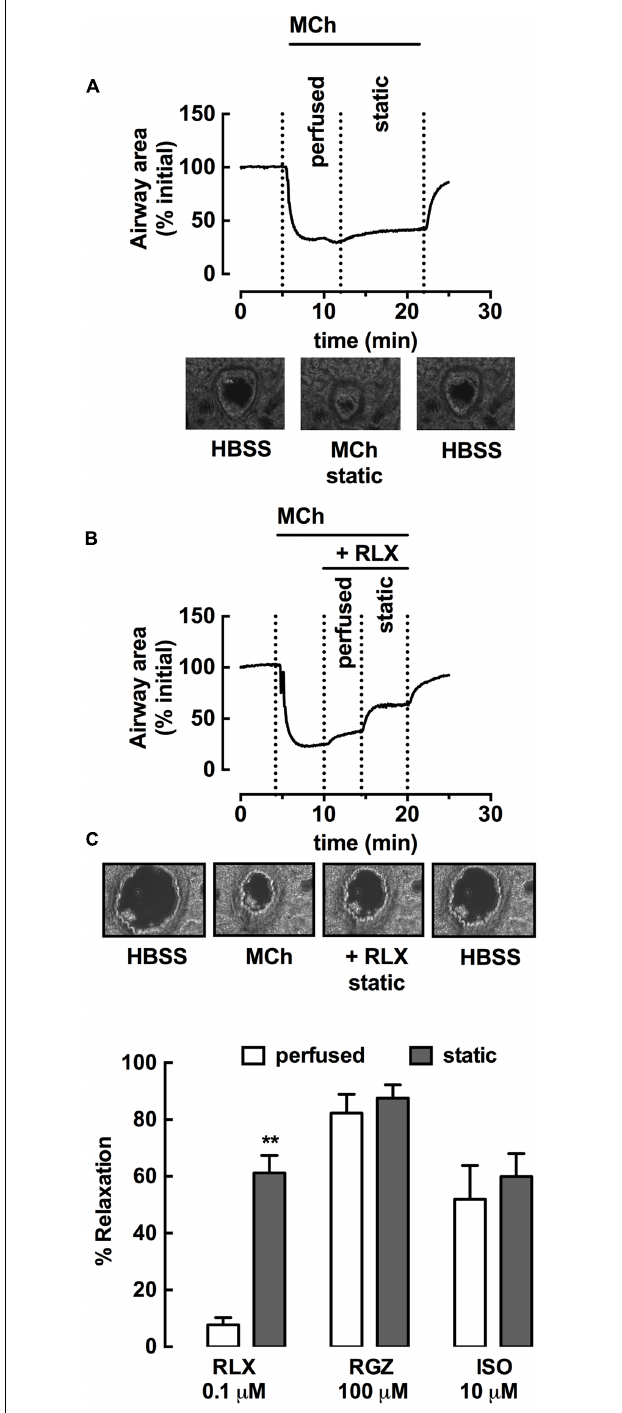
FIGURE 4 | rhRLX elicits relaxation of rat intrapulmonary airways in lung slices. Rat lung slices were mounted in a customized chamber for assessment of changes in intrapulmonary airway area by phase-contrast microscopy. Airways were pre-contracted with MCh (0.3 µ M) under perfused and static conditions, in the absence and presence of rhRLX (RLX, 0.1 µ M). Representative time-course and phase-contrast images of the last frame